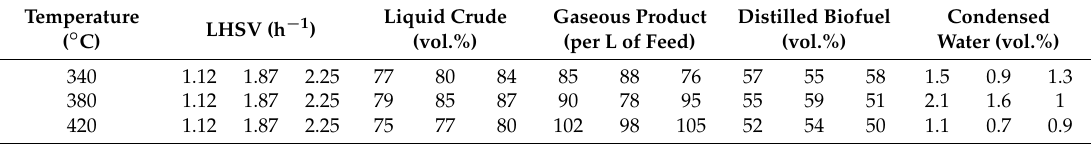
Table 14. Experimental results of Jatropha oil cracking over titania (SAT).